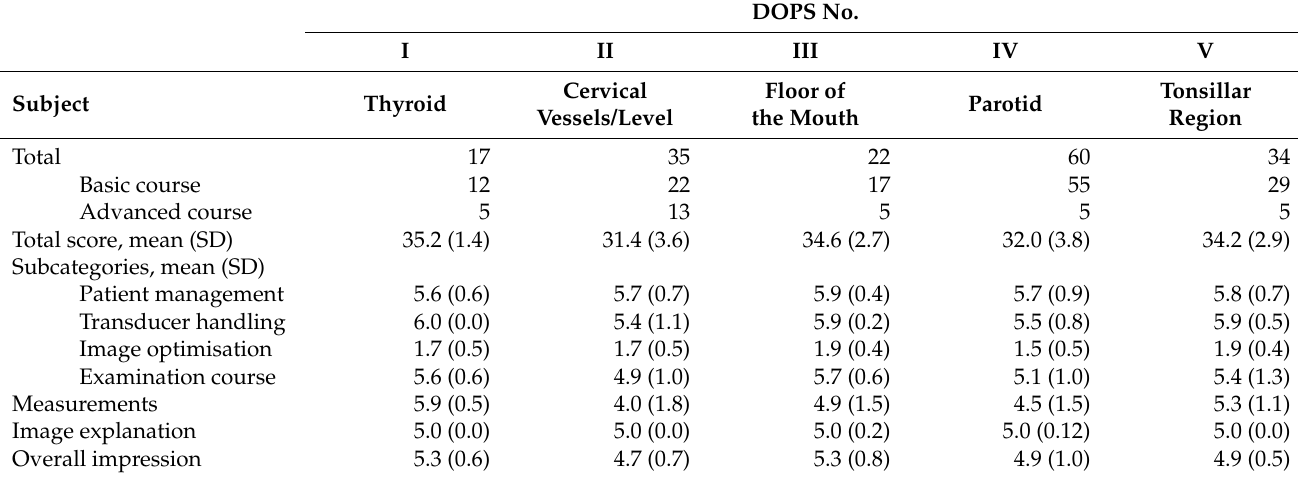
Table 3. Results of the direct observation of procedural skills (DOPS) I–V tests conducted. DOPS